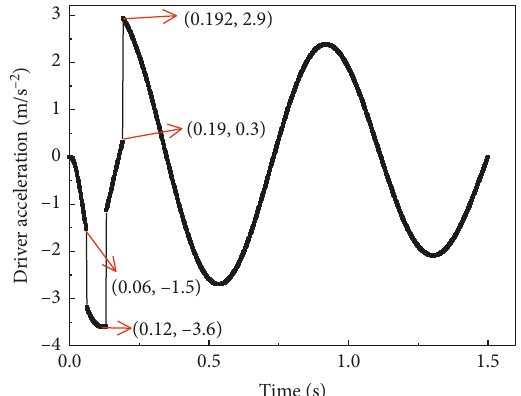
Figure 2: Development law of driver acceleration with